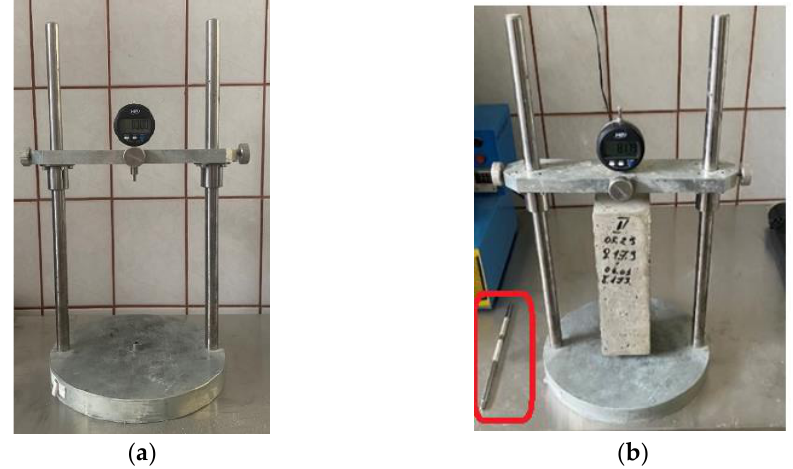
Figure 3. Views of the measurement device of the concrete prism shrinkage: without a specimen ( a ); with a specimen ( b ). Calibration tool is marked in red.